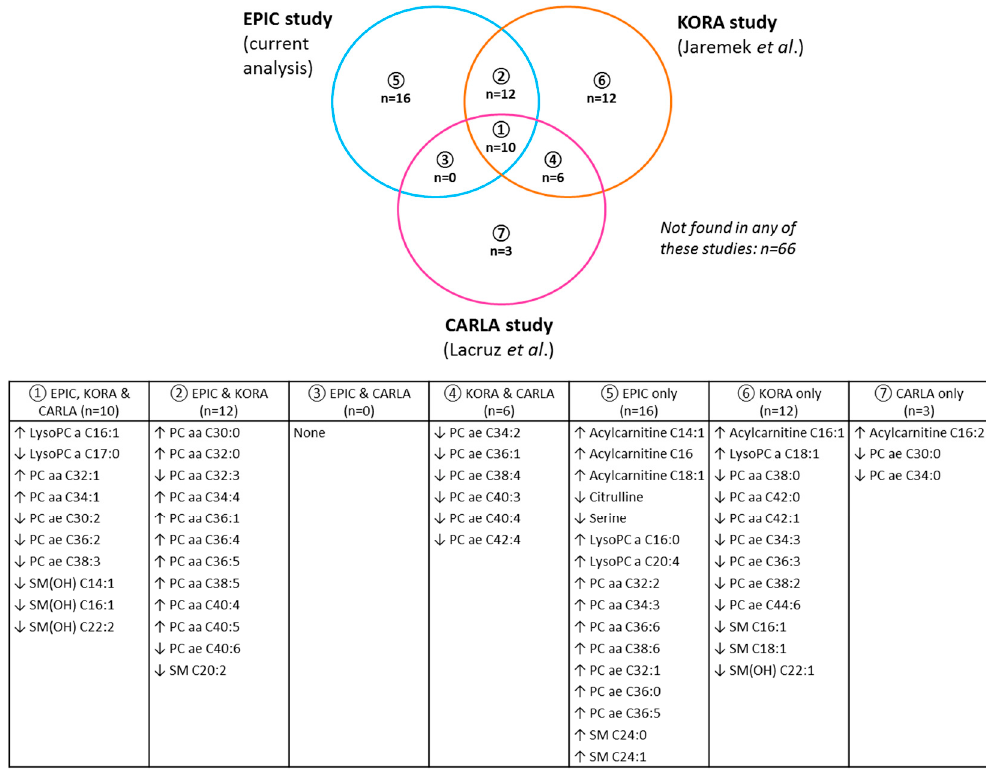
Figure 3. Venn diagram showing overlap in metabolites identified as significantly associated with alcohol intake after discovery and replication analysis in the current study (EPIC) and those identified by two other previous German population-based studies that were described by Jaremek et al. [9] (KORA study; sex-stratified analysis in 1144 men and 946 women) and Lacruz et al. [10] (CARLA study; combined analysis in 534 men and 496 women), that applied the previous version of the assay used in the current analysis (i.e., BIOCRATES AbsoluteIDQTM p150 kit; p180 kit was used in the current analysis). An upwards arrow indicates a positive association (i.e., higher alcohol intake associated with higher blood concentrations of the metabolite), while a downwards arrow indicates a negative association (i.e., higher alcohol intake associated with lower metabolite concentrations).